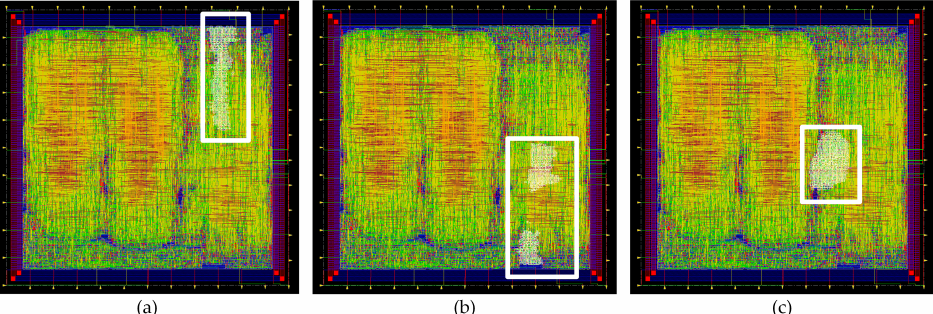
Figure 5. Layout of the ASIC highlighting the location of the ( a ) multi-radix × 2 low power Trivium, ( b ) multi-radix × 8 low power Trivium and ( c ) multi-radix × 16 low power Trivium.